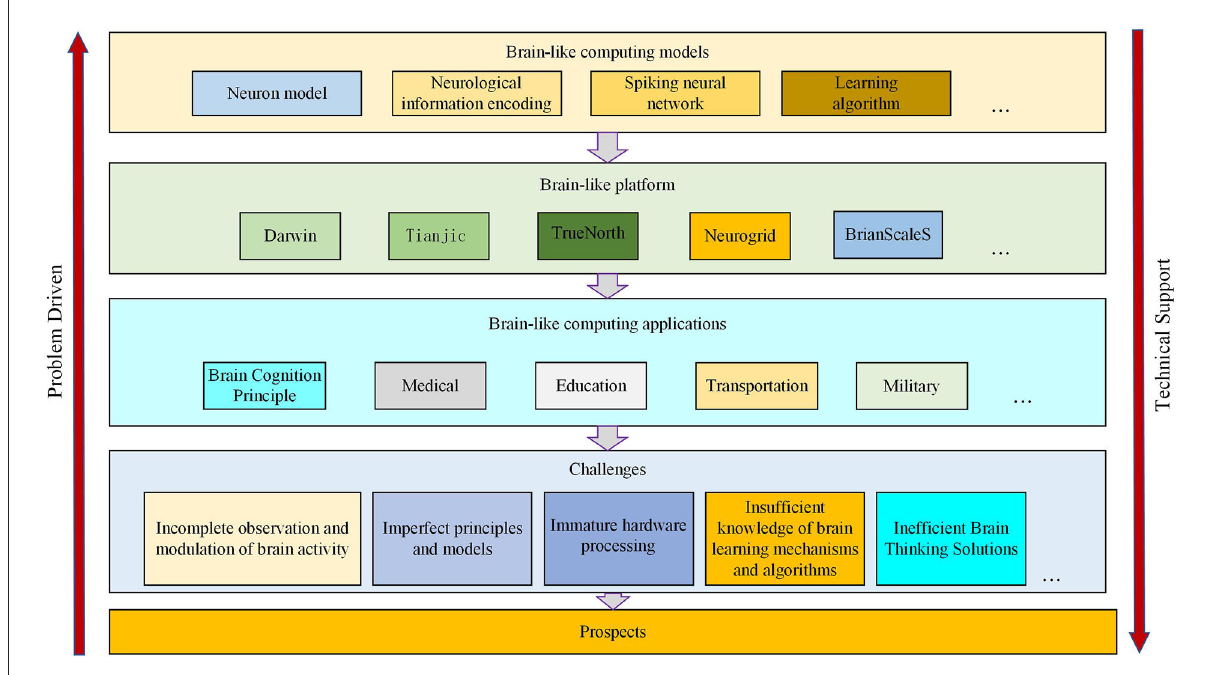
FIGURE1 The structure of the article is as follows the analysis of relevant models, the establishment of related platforms, implementation of related applications, challenges, and